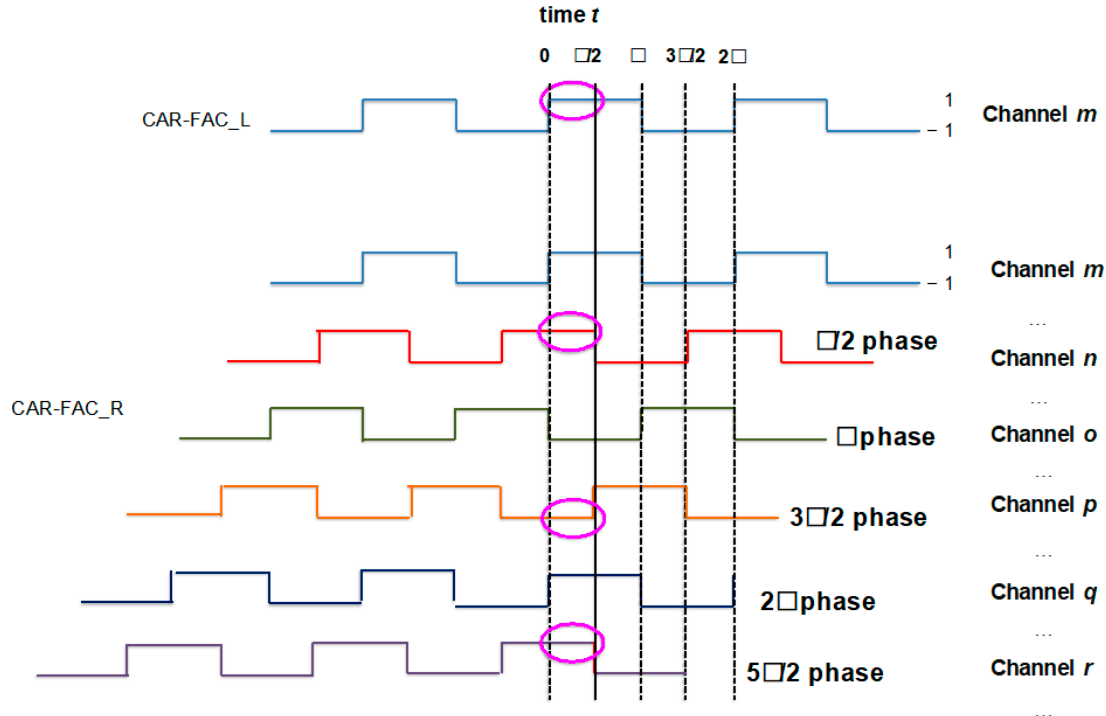
Figure 5. Quantised instantaneous cross-correlation calculation schematic diagram: The phase shift of the CAR-FAC_R (channel m to channel r ) with respect to channel m of CAR-FAC_L at time t . The magenta circles mark the phases of different channels at time t